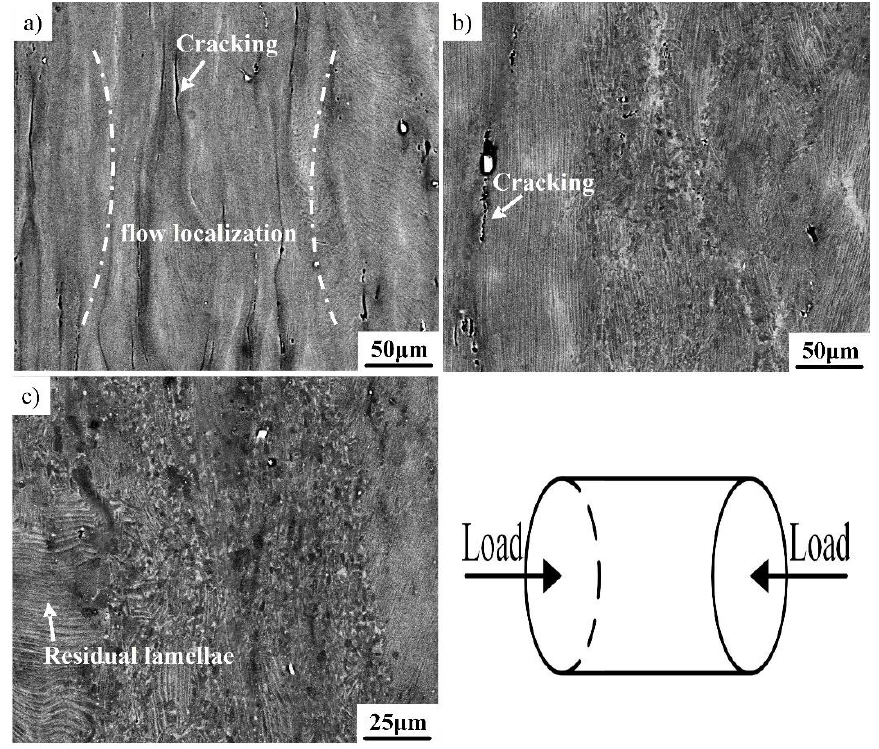
Figure 4. The microstructure of the Ti – 43Al – 3Mn – 2Nb – 0.1Y alloy compressed at 0.5 s − 1 . ( a ) 1100 °C, ( b ) 1200 °C, and ( c ) 1250 °C.